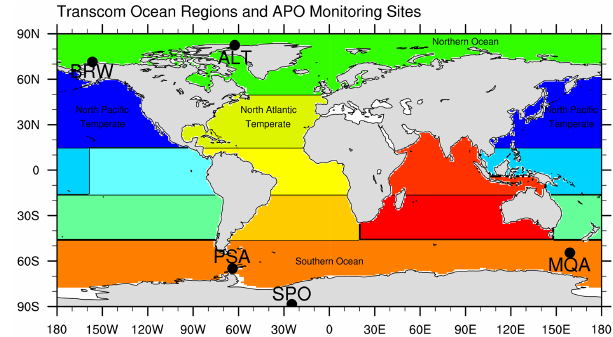
Figure 1. TransCom3 Level 2 ocean regions used in the matrix- based atmospheric transport method. Locations of the five APO monitoring sites featured in Fig. 2 are